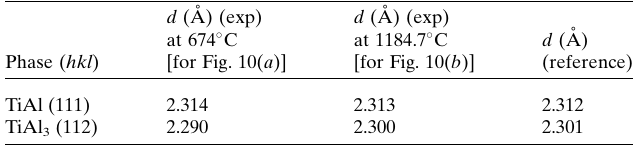
Table 3 Interplanar phase distances for diffractograms in Fig. 9.